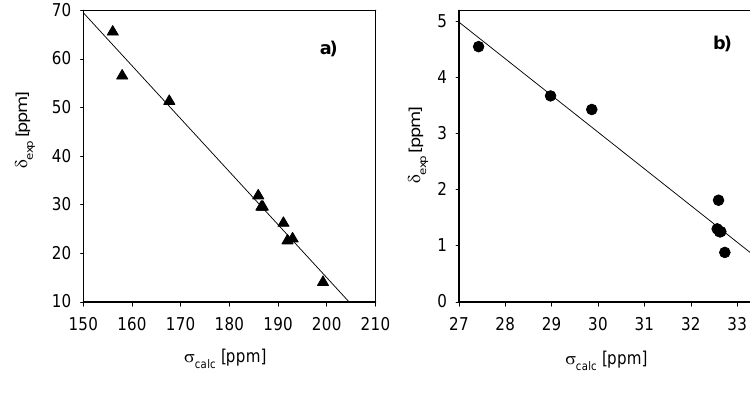
, CD Cl) in ethylene-1,2-bis( N,N -dimethyl- N - exp 3 from the calc) = a + b σ : (a) 13 C and (b) 1 H. exp calc